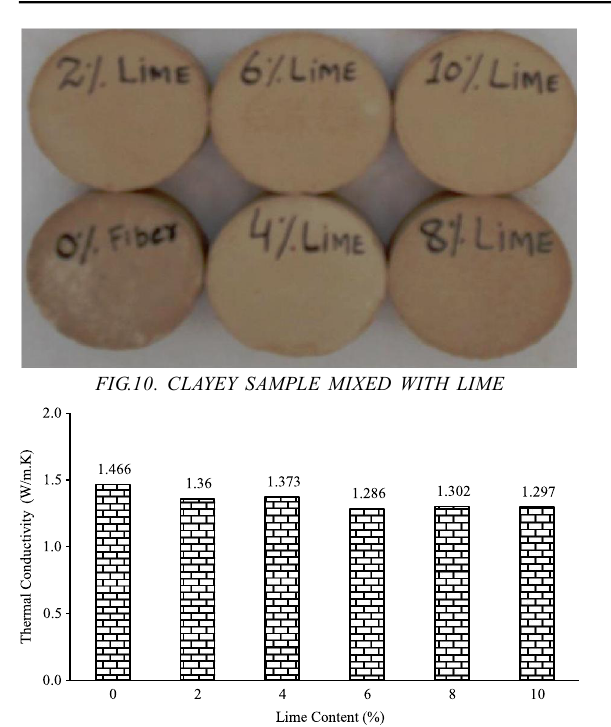
FIG. 11. EFFECT OF LIME ON THE THERMAL CONDUCTIVITY